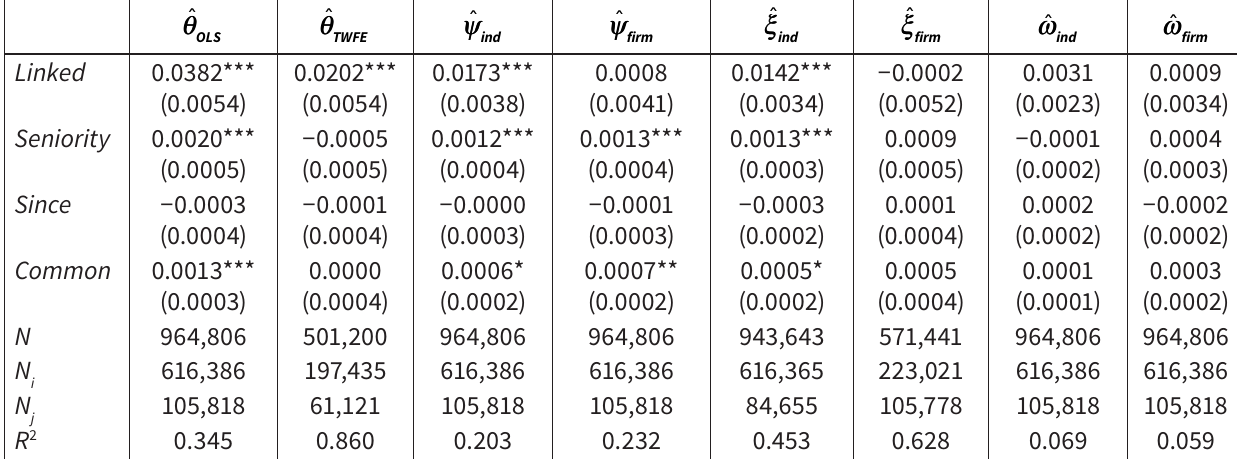
Heterogeneity of co-worker gains by link and tie characteristics θθ ˆ OLS